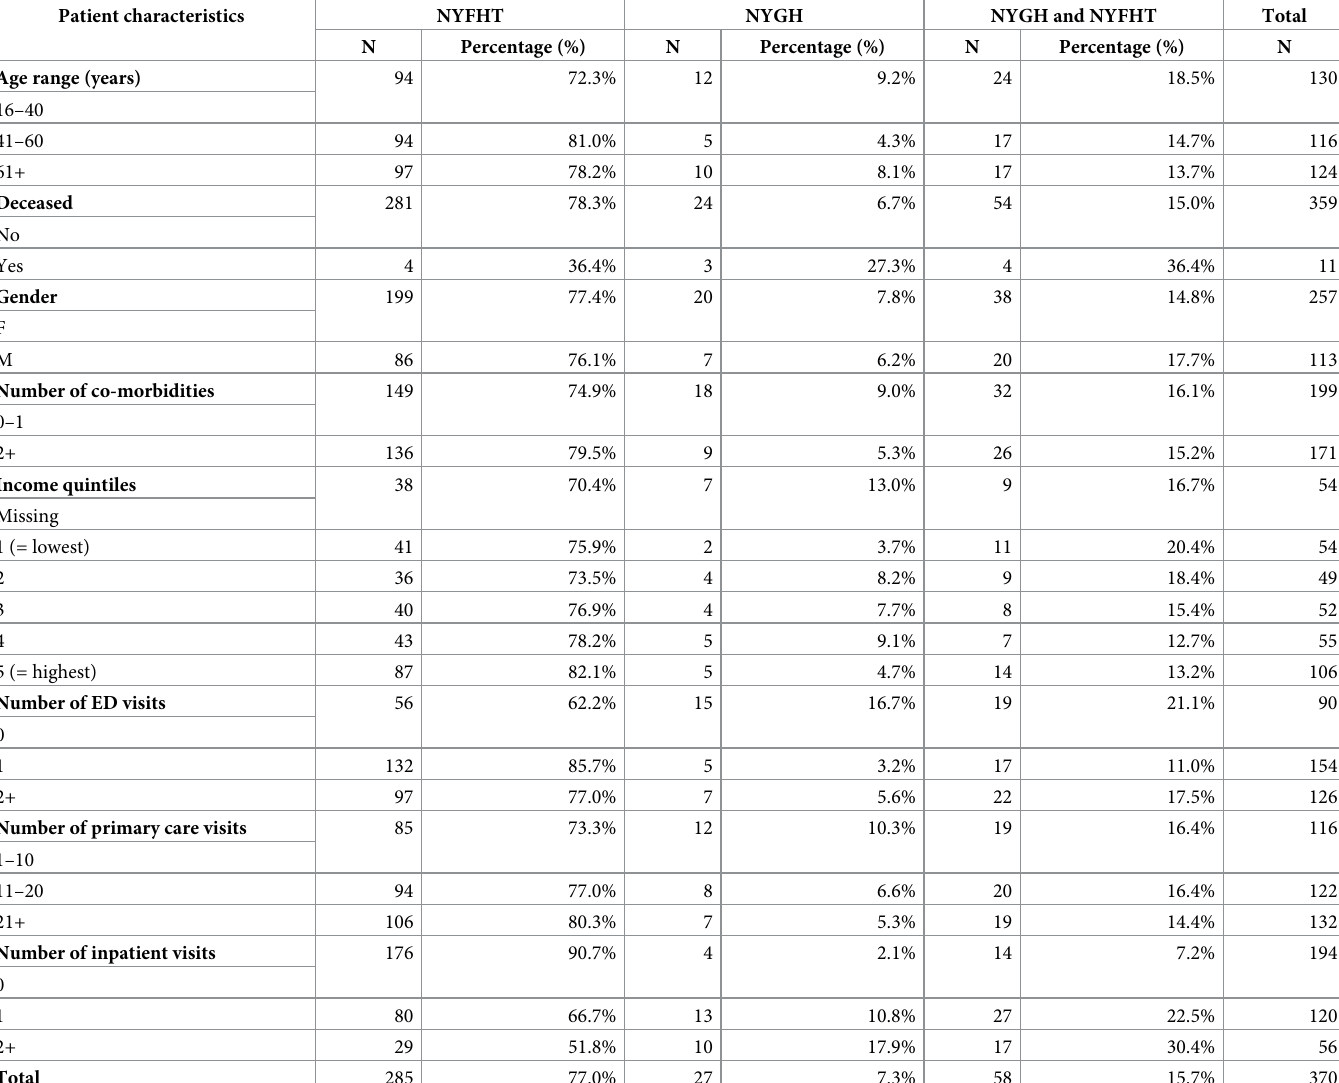
Table 2. Characteristics of patients with bipolar disorder identified in primary care (NYFHT) and hospital (NYGH) data, and those identified in both settings. Patient